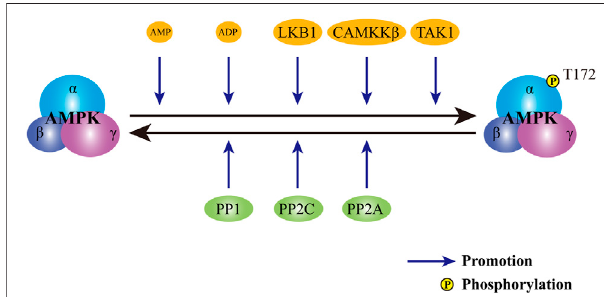
FIGURE 2 | Regulation of AMPK activity. The activity of AMPK is subject to the control of both activators and inhibitors. Upon the stimuli of activators, including AMP, ADP, LKB1, CAMKK β and TAK1, AMPK is phosphorylated and activated. In contrast, phosphatases, including PP2A, PP2C and PP1, dephosphorylates AMPK to avert persistent activation of AMPK. AMPK: AMP-activated protein kinase; AMP: adenosine monophosphate; ADP: adenosinediphosphate. LKB1: livekinase B1;CAMKK β : calcium/calmodulin- dependent protein kinase kinase β ; TAK1: transforming growth factor- β activated kinase 1; PP2A: protein phosphatase 2A; PP2C: protein phosphatase 2C; PP1: protein phosphatase